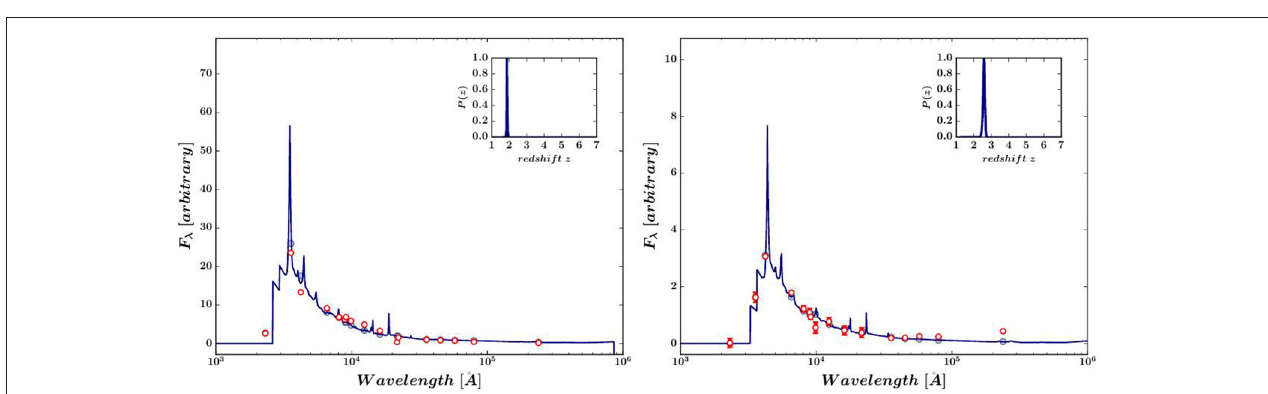
FIGURE 2 | Typical examples of the spectral energy distribution for two candidate quasars identified using our selection method. In each case the best-fit quasar template (as derived from the EAZY calculation) is also plotted. Red circles are the photometric points and the blue circles indicate the predicted photometry by the best-fit template. The phometric redhifts for objects are 1.87 and 2.57, respectively. The probability density distributions (PDFs) for each object are shown in the small inset. These PDFs strongly suggest that these objects are located at high-z. The Ly α line in the two candidate quasars is clearly identified as an abrupt break in the quasar SED between the NUV-GALEX band and U spec and B w filters, respectively.